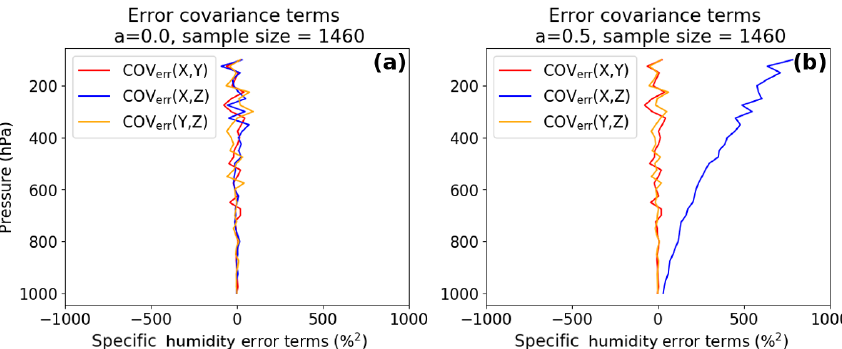
Figure 2. Vertical profiles of normalized error covariances ( X,Y ), ( Y,Z ) and ( X,Z ) for (a) a = 0 and (b) a = 0 . 5.